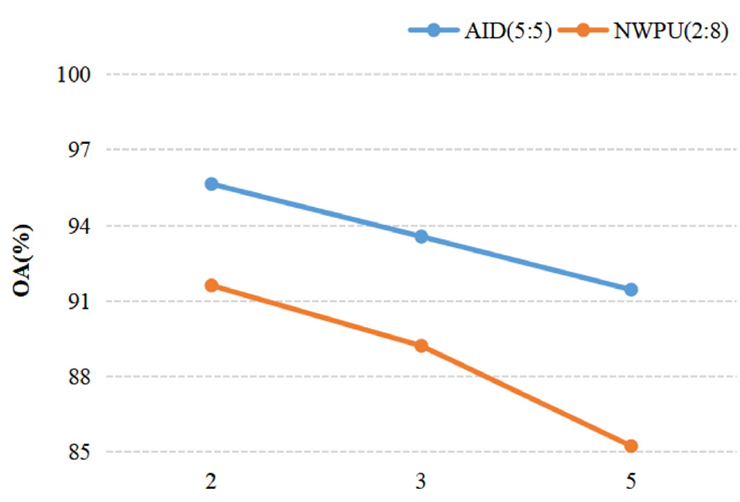
Figure 11. The influence of the Conv kernel size.